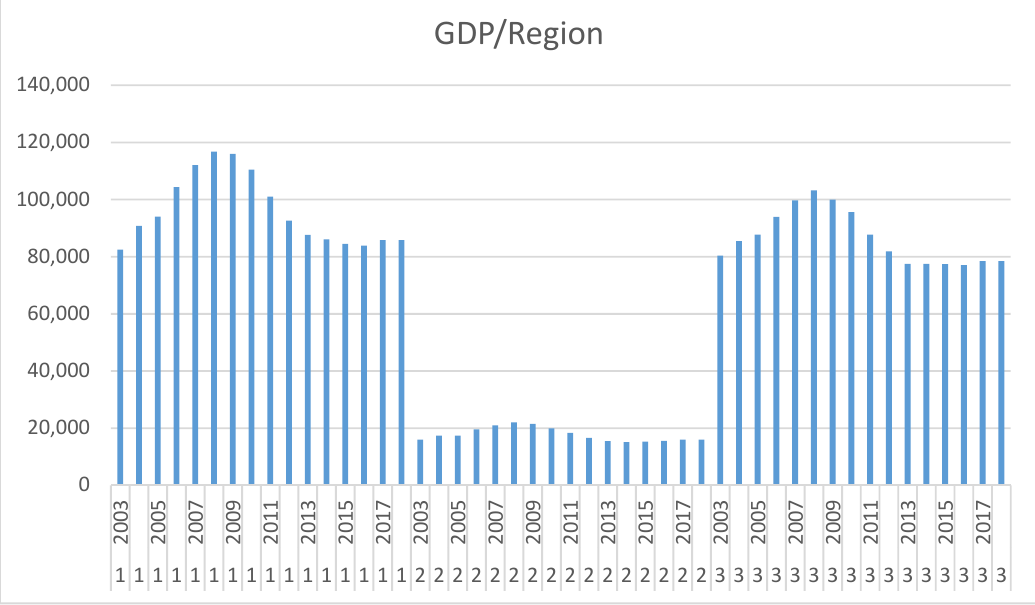
Figure 3. GDP in mil. euros per region/year (2003–2018). Notes: Region 1 (Athens), Region 2 (Thessaloniki), Region 3 (Other Areas—the rest of Greece). Source of data: Hellenic Statistical Authority.